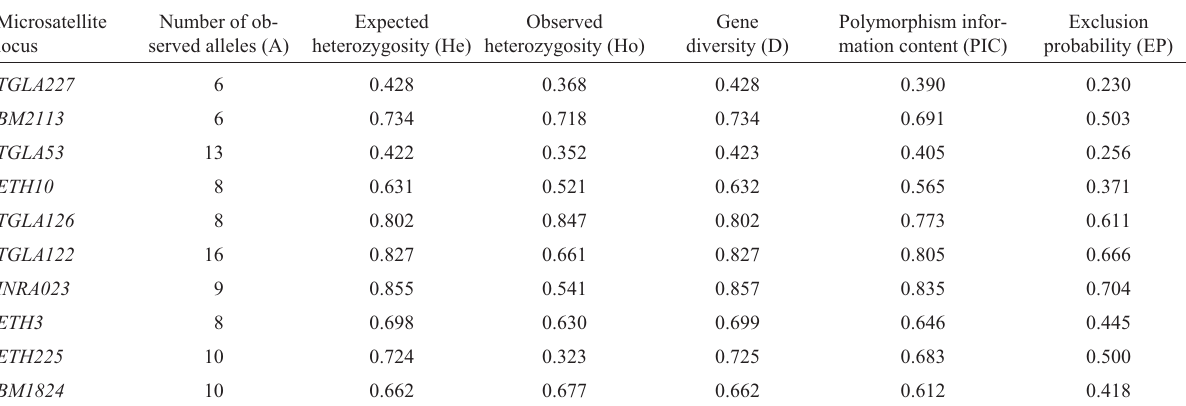
Expected heterozygosity (He)